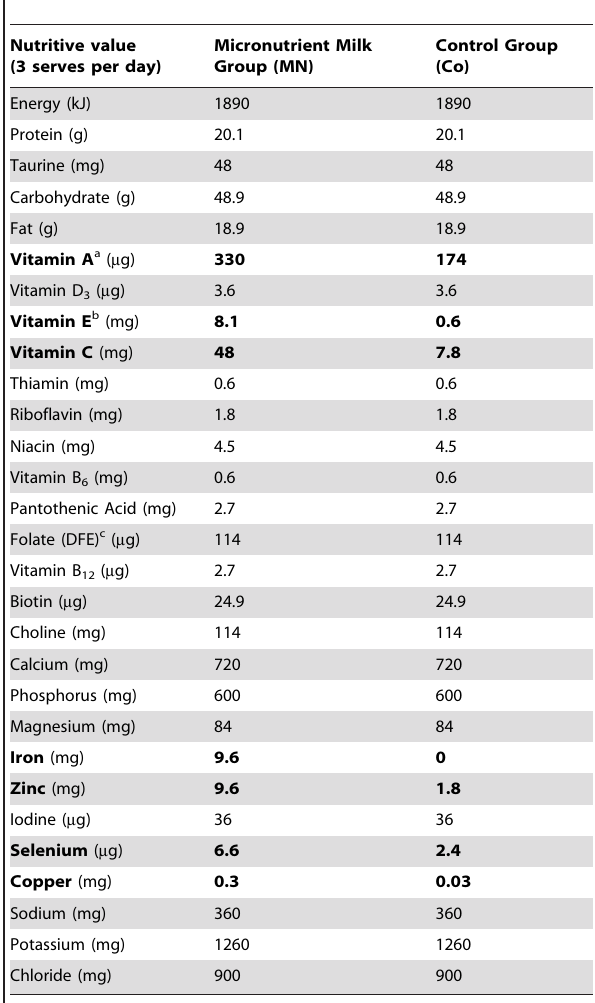
Table 1. Composition of micronutrient fortified milk vs. control milk (cheap regular milk used as base